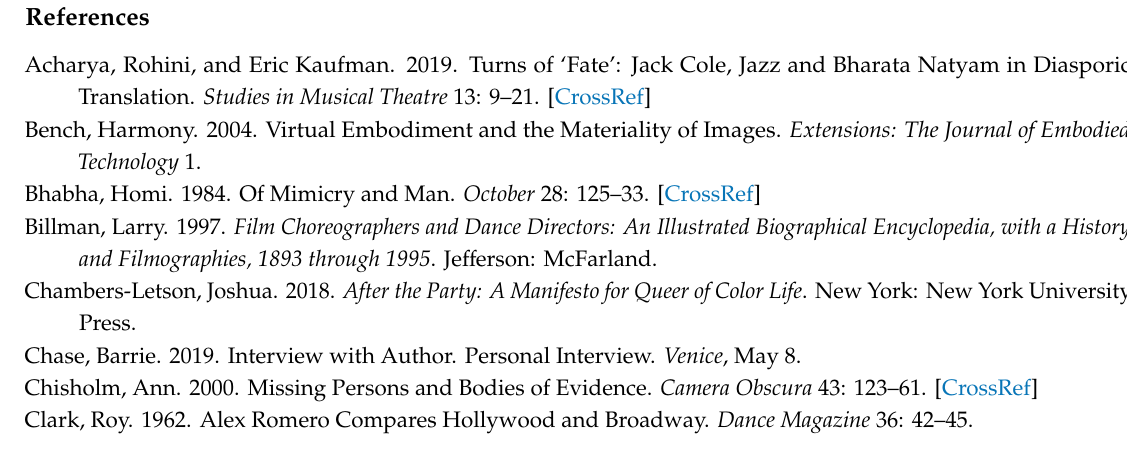
Brother Grimm (1962). Photographs by Seymour Linden for Dance Magazine (January 1962).